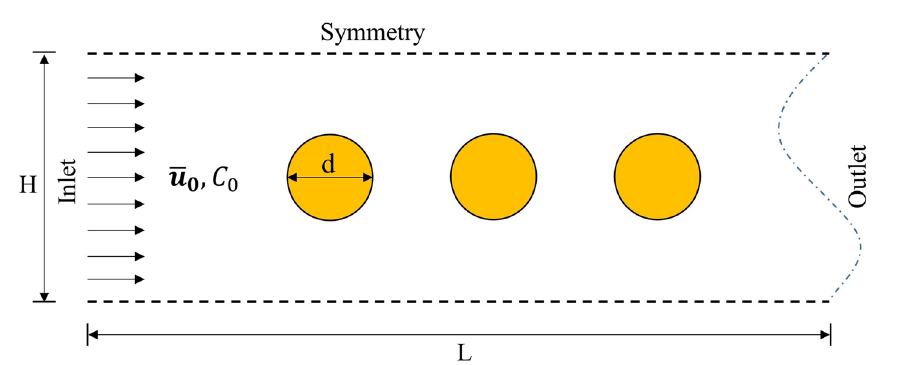
Figure 6. Schematic representation of a simulation setup for of reactive flow through porous to the previous studies by Soulaine et al. 24 . The schematic representation of the simulation system is shown in Fig. 6. The height ( H ) and width ( W ) of the simulation domain were varied to adjust the porosity of the repre- sentative elementary volumes. The radius of spherical particles is R = 100 µ m and the length of the simulation domain ( L ) is set as L = 3 mm. Four spherical particles were arranged along the centerline of the simulation domain in the x-direction along the flow direction. The distance between two particle centers was 200 µ m . The supersaturated solution of barium sulfate flowed into the simulation domain from the left side inlet at a constant − u 0 = 5 µ m SI = log (� ), of reactive solution at the inlet is 3 (any higher an SI has speed of s . The saturation index, resulted in homogenous nucleation in experiments 45 ). The right side boundary was set as an outlet boundary condition. The other four sides of the simulation domain were set as symmetric boundary conditions to mimic a large porous medium in both y and z -directions. All other parameters regarding the barite precipitation are the same as the ones used in the validation case. To investigate the effect of geometrical constraints on the precipitation process, we gradually change both the ratios H / d and W / d simultaneously from 1.05 to 1.5 and keep the other inputs unchanged. Such constrains demonstrate the permeability/porosity changing (reduction of H / d ) in porous materials that results in reduced − u 0 d pore , where d pore transport of species. To demonstrate the results in terms of Pe number we introduce Pe pore = D is the hydraulic diameter of the pore. The total precipitated solid mass was obtained by integrating solid mass in each cell through the whole computational domain. It was observed that the total precipitated solid mass decreases as the simulation domain became narrower (see Fig. 7). The total amount of precipitated solid mass in the H/d = 1.1 ( W / d = 1.1) case was only about 55% of the solid mass in the H/d = 1.5 case. Another observa- tion from the simulation results is that the precipitation follows a linear growth in all cases even though the geometrical constraint was imposed by shrinking the size of simulation domain. This difference in total amount of precipitate is likely limited by transport of species from the upstream flow. As the size of the simulation domain shrinks, the transport pathway from the inlet decreases as well. This effect correlates with the reactive species concentration distribution as shown in Fig. 8. The concentration gradually decreases downstream from the inlet due to the consumption of reactive species. For H/d = 1.5, the gradient of concentration is lower compared to the H/d = 1.1 case. Such observation demonstrates the permeability/porosity